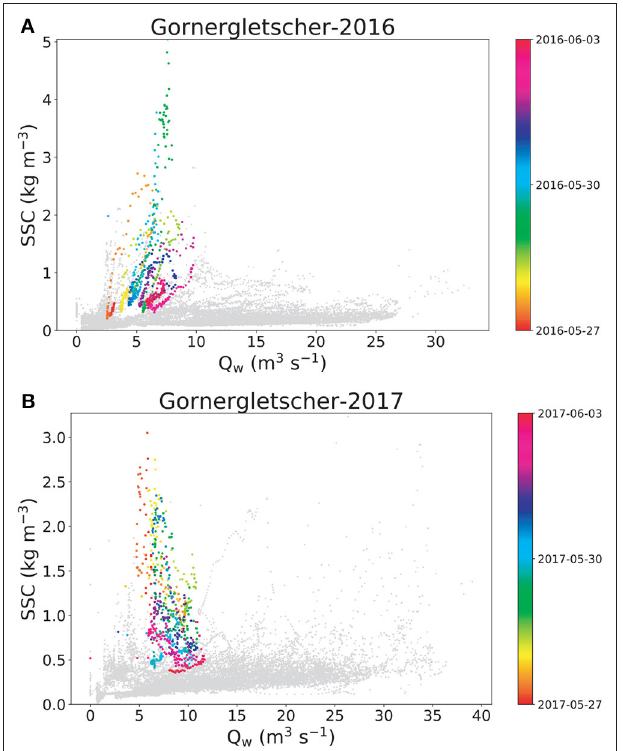
FIGURE 7 | Relationship between water discharge (Q w ) and suspended sediment concentration (SSC) at the Gornergletscher catchment during the 2016 (A) and 2017 (B) seasons. Data during lake drainages are shown by colored dots, while gray dots represent season-long relationship.